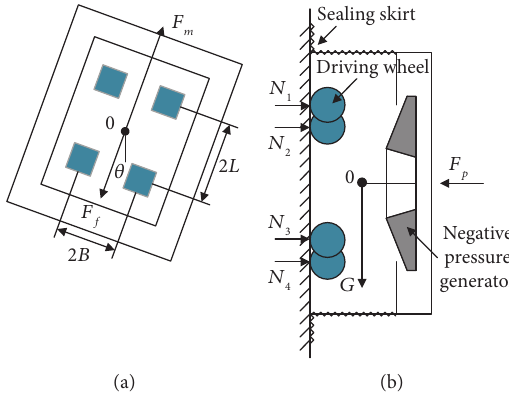
Figure 5: Force diagram of the wall-climbing robot with any